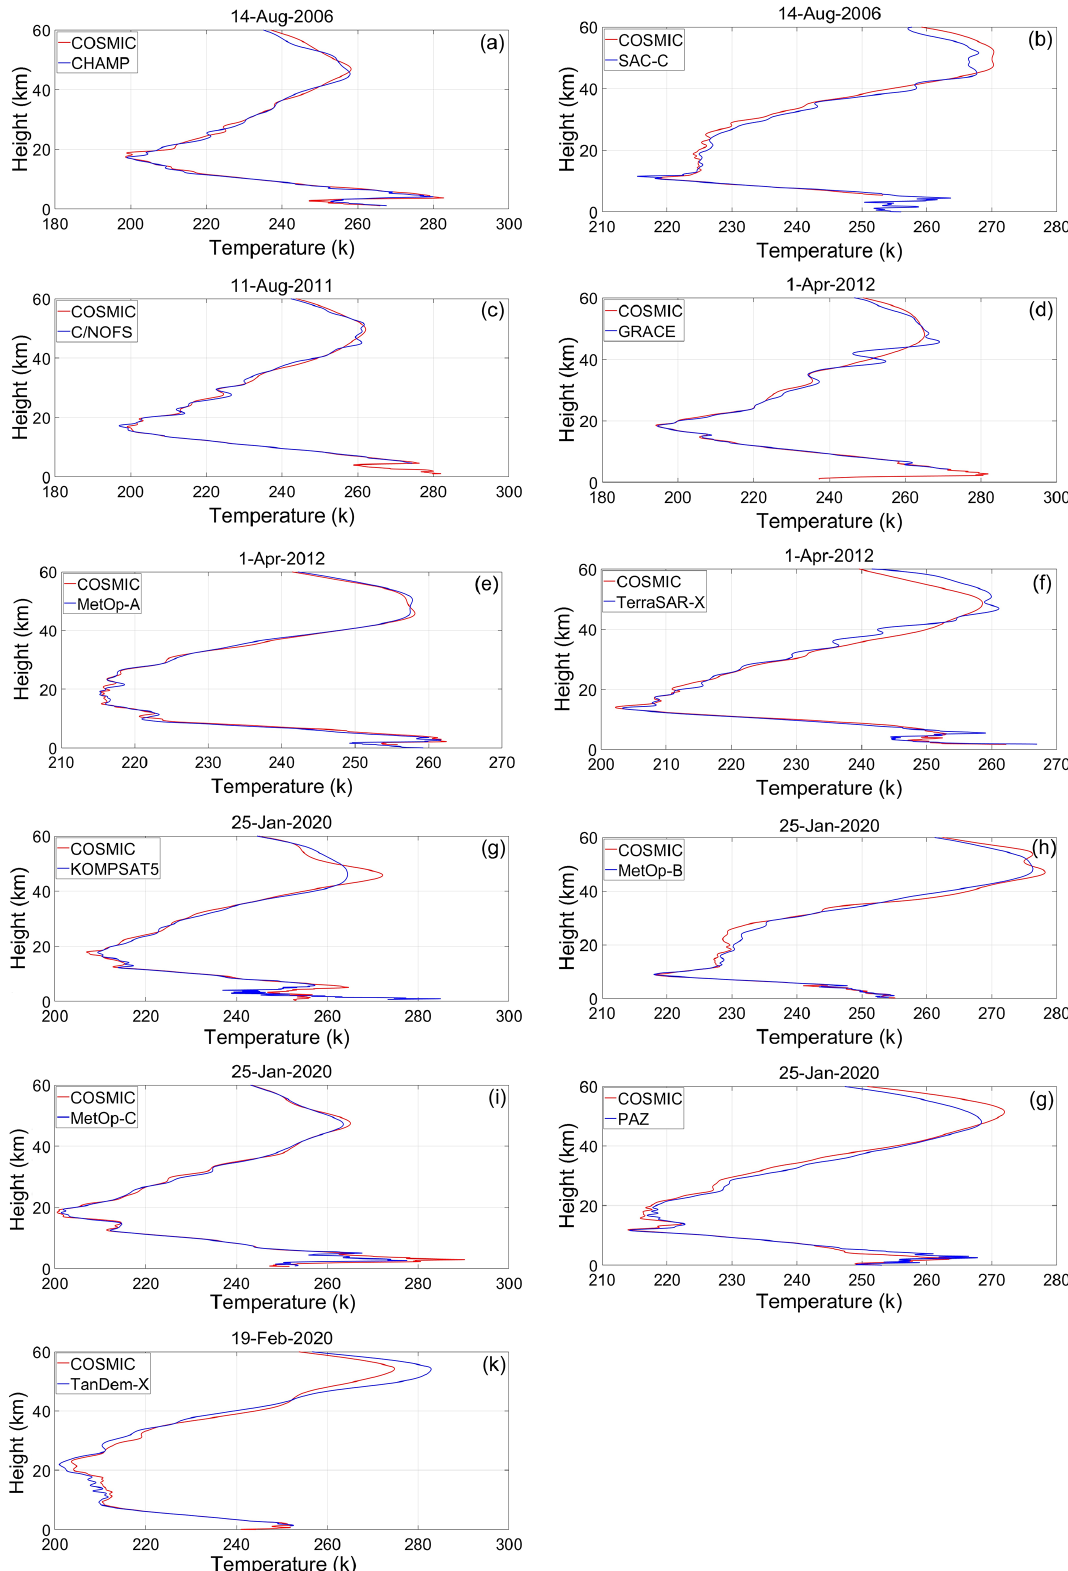
Figure 2. Intercomparison of collocated GNSS profile